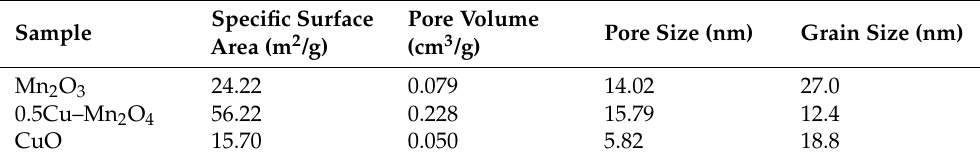
Figure 3. XRD patterns ( a ) and Raman spectra ( b ) of Mn 2 O 3 , 0.5Cu–Mn 2 O 4 , and CuO. Figure 3. XRD pa tt erns ( a ) and Raman spectra ( b ) of Mn 2 O 3 , 0.5Cu–Mn 2 O 4 , and CuO. Table 1. Specific surfaces areas and pore properties of catalysts. Table 1. Speci fi c surfaces areas and pore properties of catalysts.